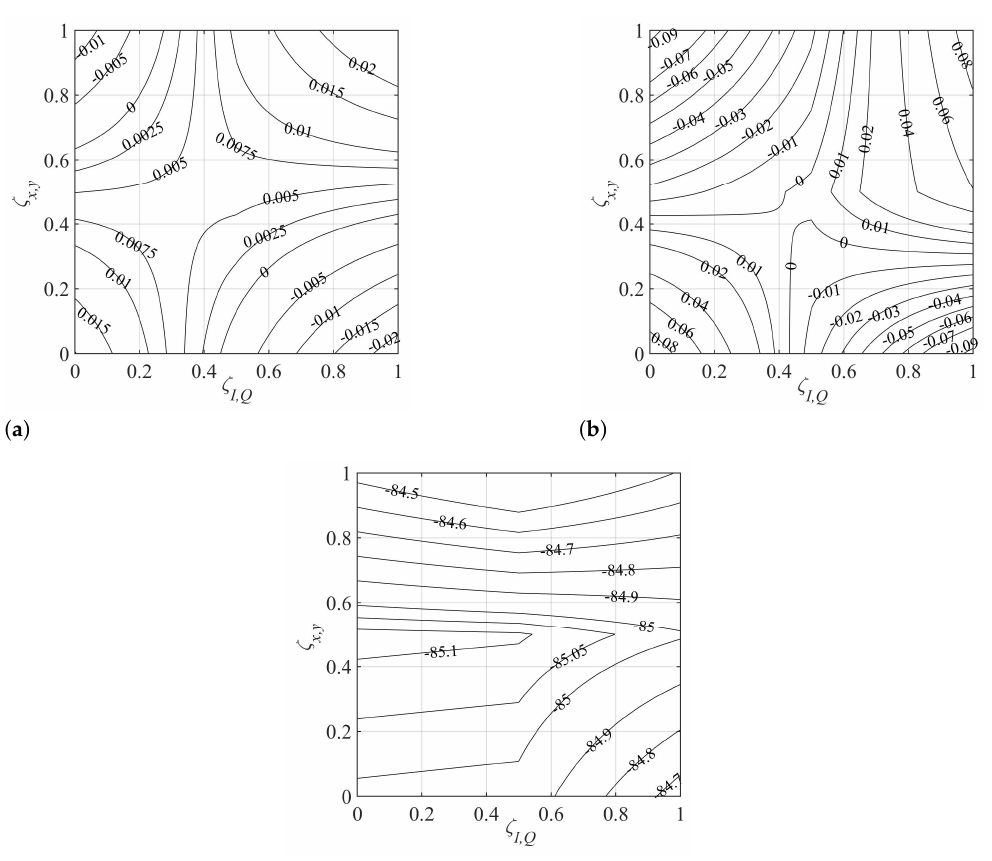
Figure 5. ( a ) Normalized mean of the I component of the ICXT field in the x direction at the interfered core output; ( b ) correlation coefficient between the I component of the ICXT field in the x direction and the I component of the ICXT field in the y direction at the interfered core output; and ( c ) mean power of the Q component of the ICXT field in the y direction at the interfered core output (in dB) for (cid:0) ∆ (cid:1) β c, mn = 0rad·m − 1 homogeneous WC-MCF with L C = 10m and L B = 0.1m (regime L C (cid:29) L B